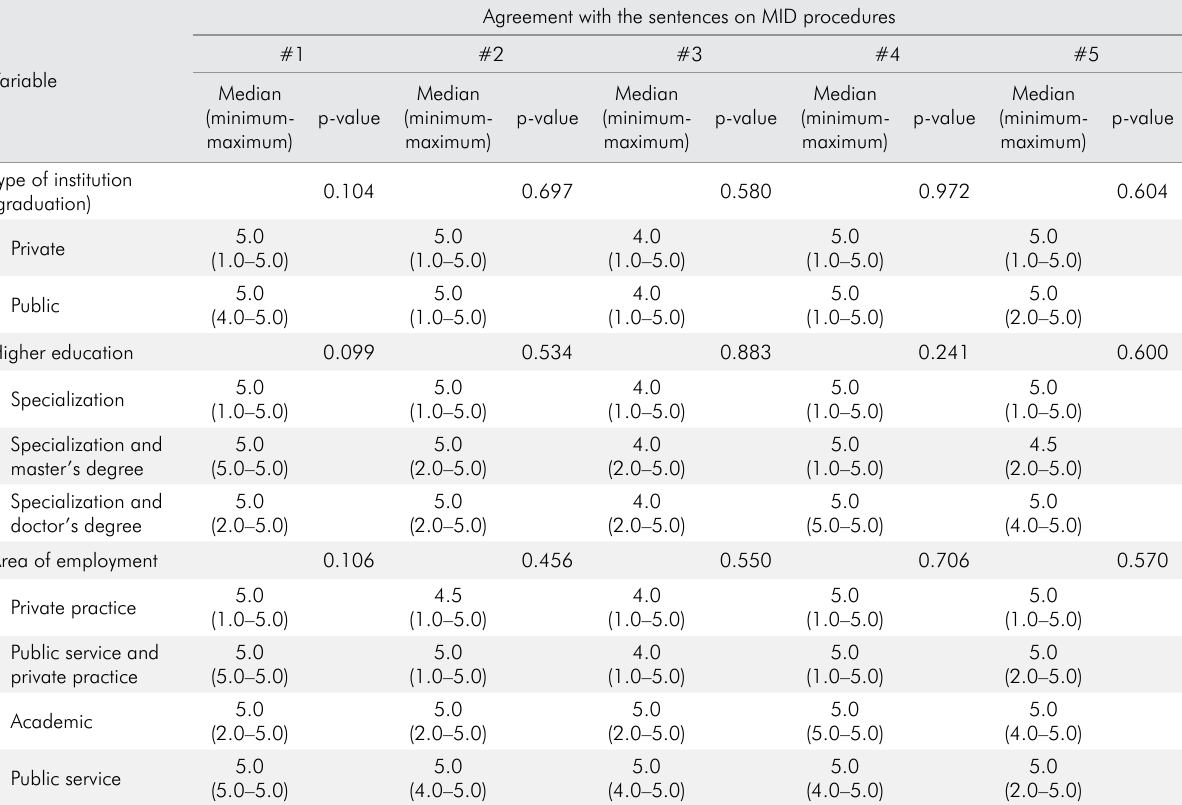
Table 5. Comparison of the level of agreement with the sentences on MID procedures between the categories of independent variables